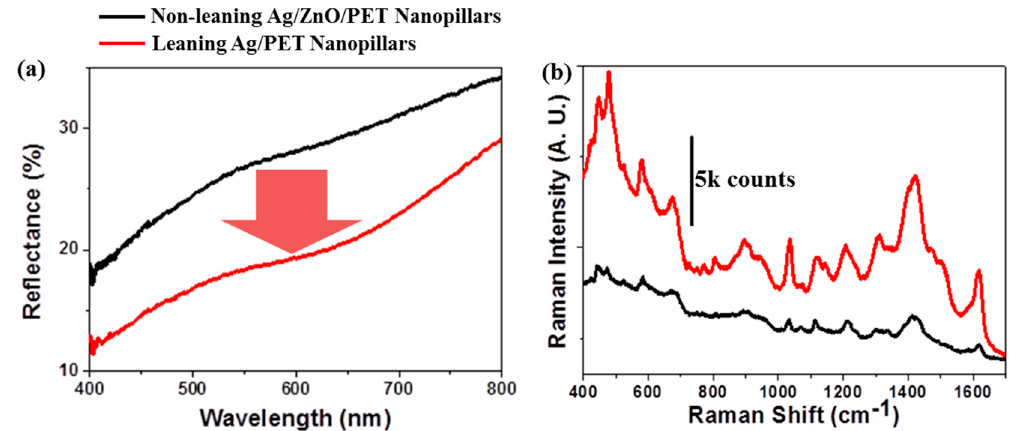
Figure 3. Optical and SERS properties of the non-leaning and leaning Ag nanostructures. ( a ) Reflectance spectra measured from the non-leaning ZnO-deposited Ag nanopillars and leaning Ag nanostructures. The reflectance intensity over the entire visible range decreased within the area containing the capillary-induced leaning Ag NPs due to the enhanced near-field coupling effects. ( b ) Raman spectra of methylene blue (MB) absorbed onto non-leaning and leaning Ag NPs. The excitation laser wavelength was 632.8 nm.